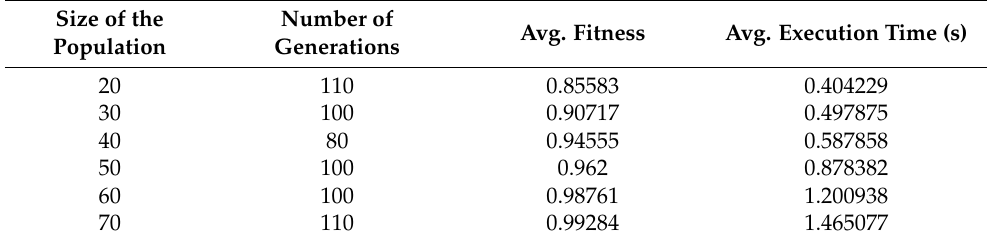
Table 4. The fitness function value sensitivity to the variation of the input parameters. Size of the